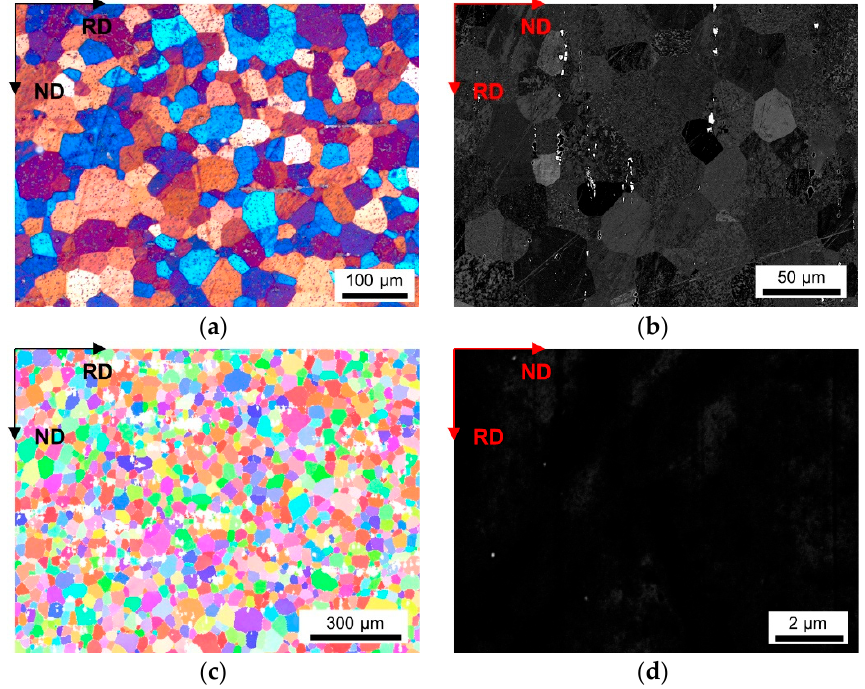
Figure A2. Microstructure of the soft annealed LFe-LMn cast under S-C condition, homogenized at 500 °C and cold rolled to a CRD of 63%. ( a ) LOM. ( b ) BSE image. ( c ) EBSD IPF map in RD–ND plane. ( d ) BSE micrograph showing dispersoids.